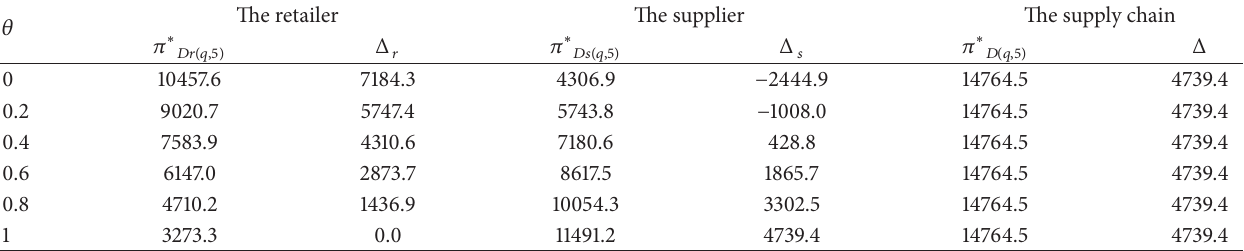
Table 2: The profit variation of the decentralized supply chain and its members with coefficient of linear transfer payment 𝜃 (from 0 to 1).